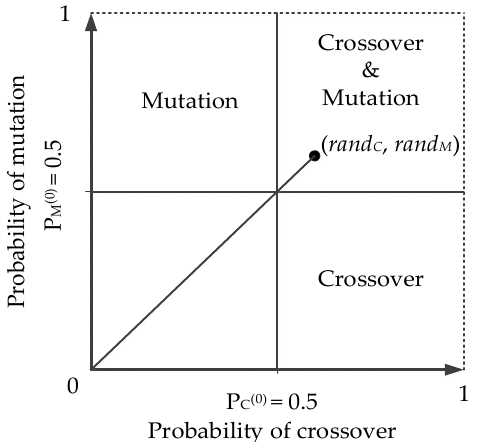
Figure 2. Initial probability map of the crossover and mutation in ICM. (2)